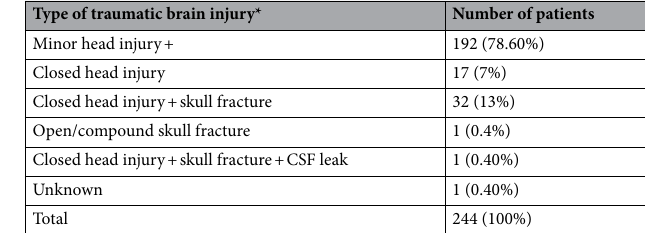
Table 2. Severity of head injury. CSF cerebrospinal fluid. *According to the 2016 US Veterans Administration/ Department of Defense (VA/DoD) Clinical Practice Guideline 45 a Traumatic Brain Injury (TBI) is defined as a traumatically induced structural injury and/or physiological disruption of brain function as a result of an external force and is indicated by new onset or worsening of at least one of the following clinical signs immediately following the event: (a) Any period of loss or a decreased level of consciousness, (b) Any loss of memory for events immediately before or after the injury (post-traumatic amnesia), (c) Any alteration in mental state at the time of the injury (i.e. confusion, disorientation, slowed thinking, alteration of consciousness/mental state), (d) Neurological deficits (e.g. weakness, loss of balance, change in vision, praxis, paresis/plegia, sensory loss, aphasia) that may or may not be transient, (e) An associated intracranial lesion (typically on imaging). + Numerous guidelines have been written on the inclusion criteria for diagnosis of a mild traumatic brain injury (mTBI) or minor head injury. Most concur that a mTBI (while recognizing it as a complex pathophysiological process affecting the brain) may or may not be associated with a loss of consciousness (LOC), clinically is associated with a Glasgow Coma Scale (GCS) of 13–15, resolution of post- traumatic amnesia within 24 h, a LOC for less than 30 min and normal intracranial imaging (CT/MRI) 17,46,47